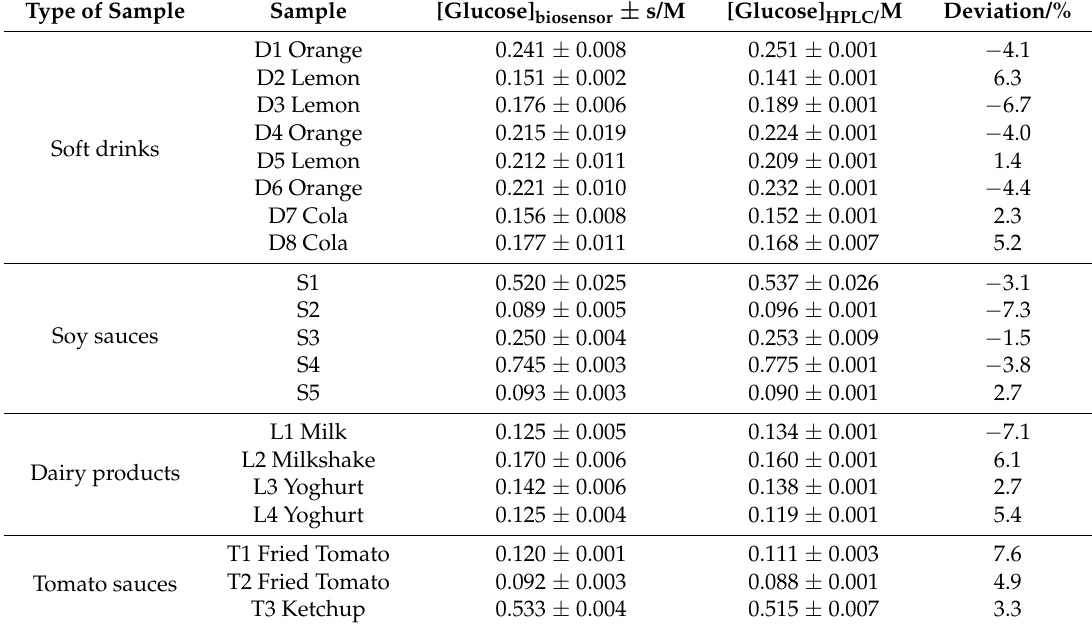
Table 6. Determination of glucose in real food samples using the Chitosa—GOx/TiO 2 NTAs/Ti biosensor and a reference HPLC method. The deviation between both methods is also